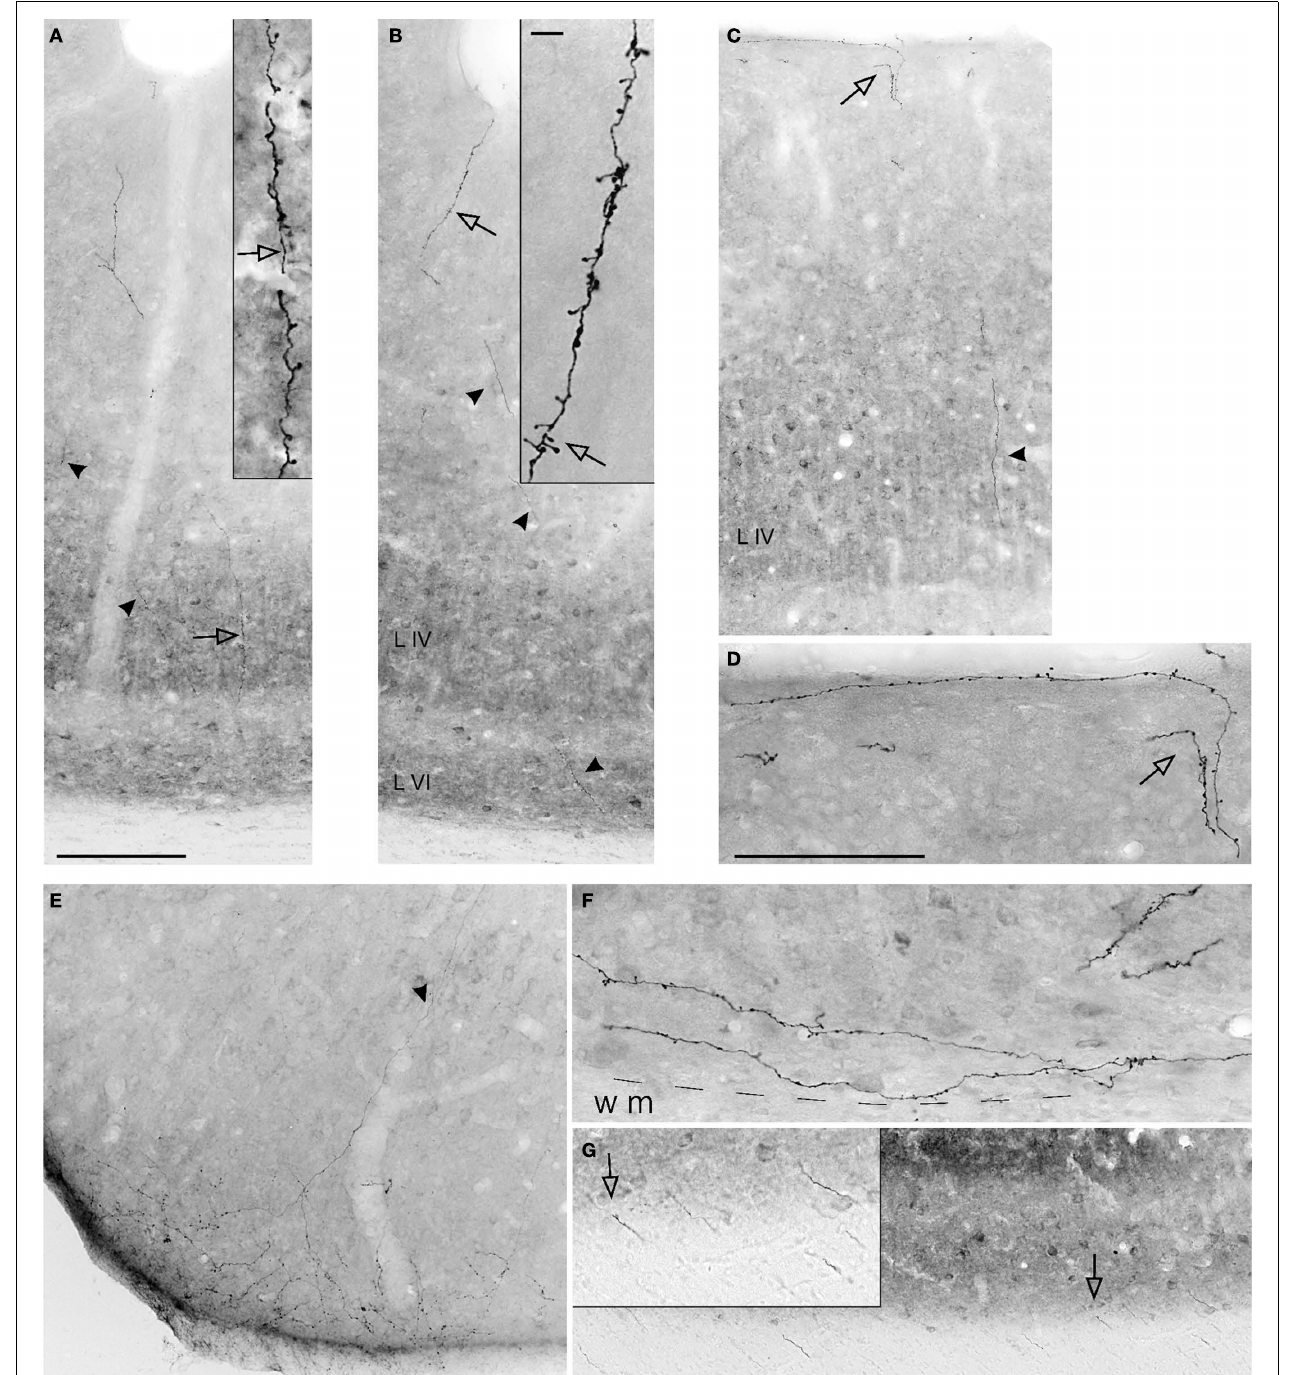
indicates an ascending axon segment. (F) BDA-labeled terminations in layerVI of areaV1.The dashed line indicates white matter border (WM). (G) A field of labeled axon segments in the white matter subjacent toV1. Inset, from hollow arrow, shows five segments at higher magnification. (E) is from Case 28, all the other examples are from Case P5. Scale bar in (A) applies to (B) and (C) (200 μ m); scale bar in the inset in (B) applies to inset in (A) (10 μ m); scale bar in (D) , applies to (F) and inset in (G) (100 μ m). Scale bars in (E) and (G) = 100 μ